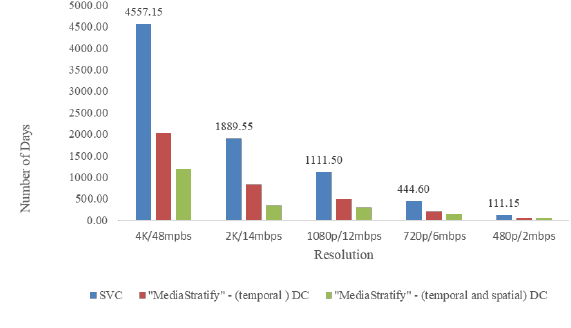
Table 2. DC sizes with and without “MediaStratify